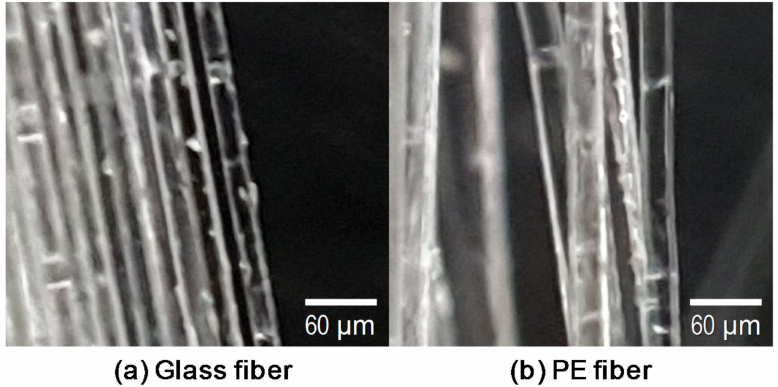
Figure 2. Pictures of ( a ) the glass fiber and ( b ) the polyethylene (PE)